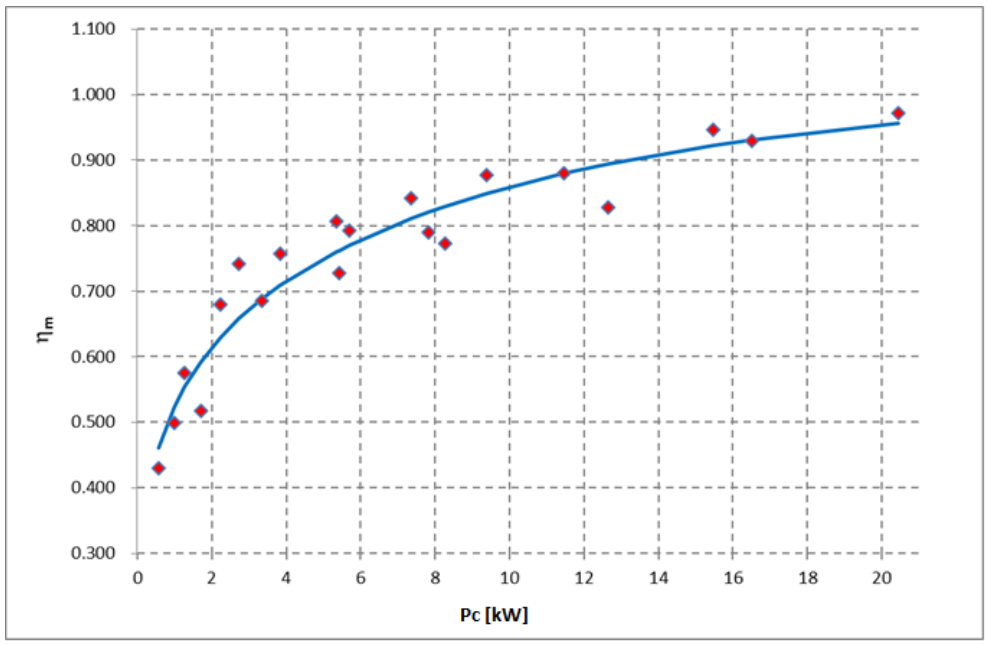
Figure 3. Turbocharger mechanical efficiency as a function of compressor power.